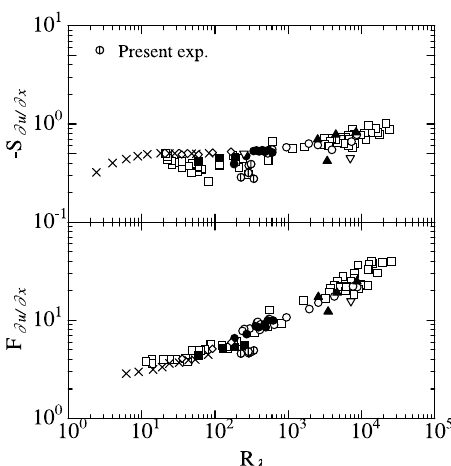
Fig. 7 Reynolds number variations of the skewness and flatness factor of the streamwise velocity derivative ∂ u /∂ x . All the data are reproduced from Sreenivasan and Antonia (1) except for the present experiments